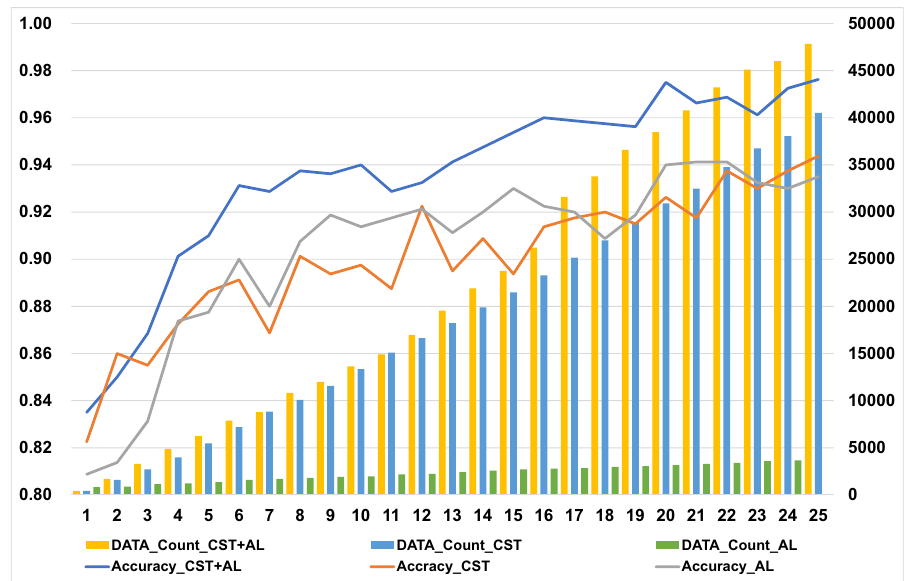
Figure 1. History of added data counts and accuracy for test data. In all three methods, an upward trend in accuracy was observed with an increasing number of rounds. At the 25th time of semi-supervised learning, CST had 11 times more data as compared to AL; nonetheless, the accuracy was similar. However, the accuracy was improved in CST + AL, which is a combination of the two methods. CST, confirmed self-training; AL, active learning; DATA, addition